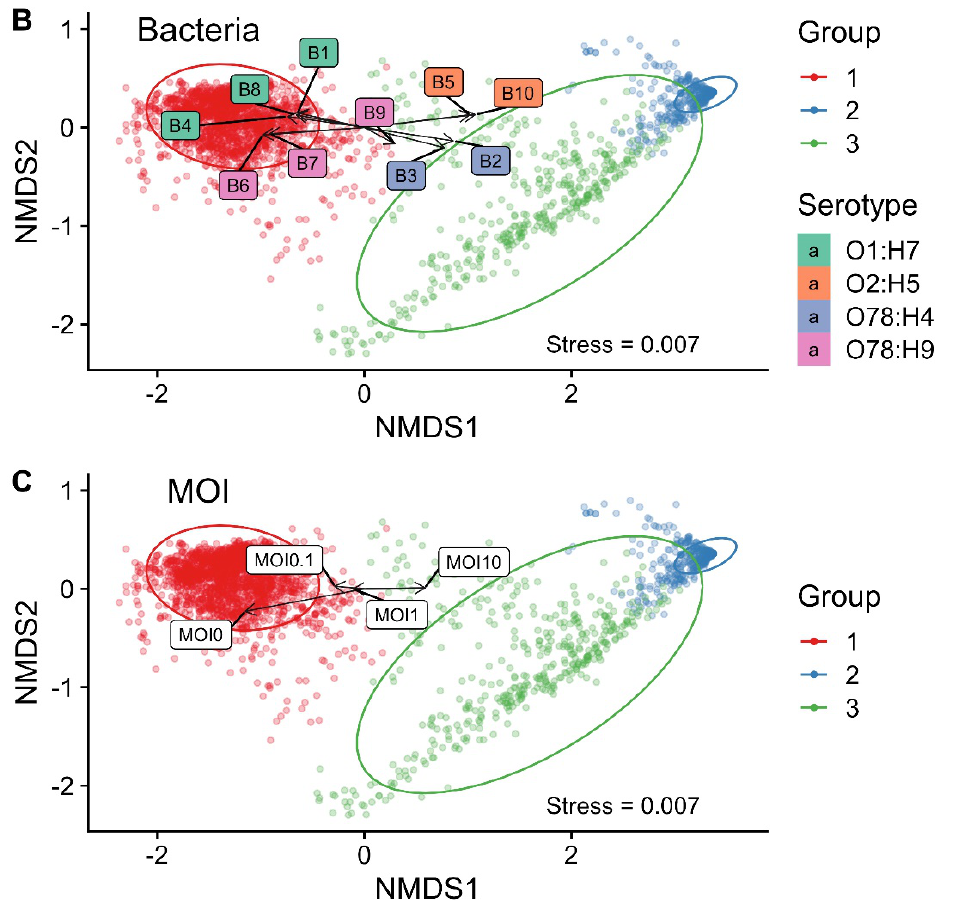
Figure 5. A nonmetric multidimensional scaling (NMDS) plot of the factors driving the grouping. ( A ) Effect of the phage type, including phage-free controls (empty). ( B ) Effect of the bacterial strain. ( C ) Effect of the multiplicity of infection (MOI). MOI 0 represents phage-free controls. A total of 2869 entities were divided into three groups. Group 1 represents resistant combinations/bacterial growth. Group 2 represents susceptible combinations/bacterial killing. Group 3 represents in-between combinations. Arrows indicate the strength and direction of the correlation. Ellipses indicate a 95% confidence level based on a multivariate t-distribution. Stress < 0.01 = a good fit.